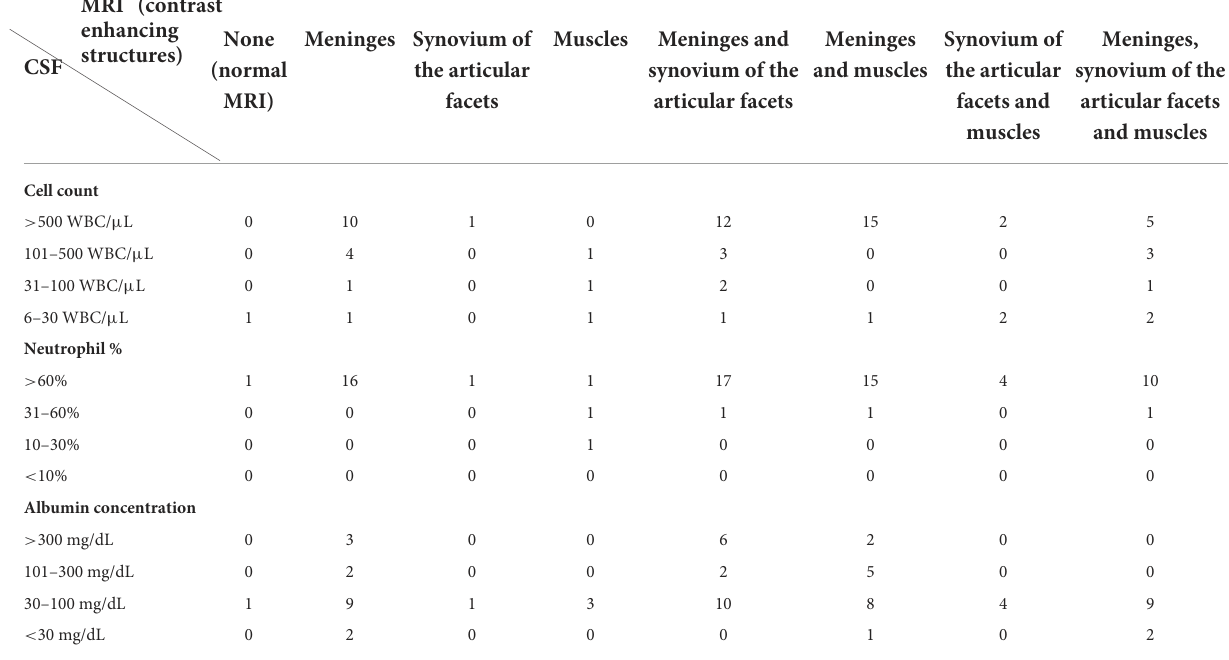
TABLE 6 Crossmatch between MRI findings (columns) and CSF findings